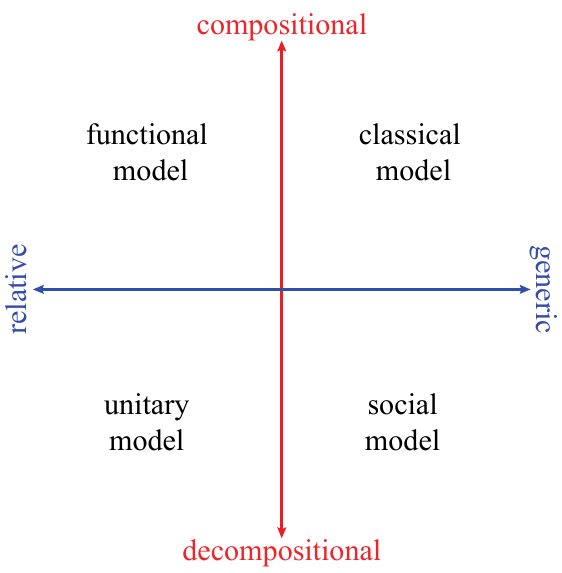
Figure 1: Four “mereological models” as discussed in the